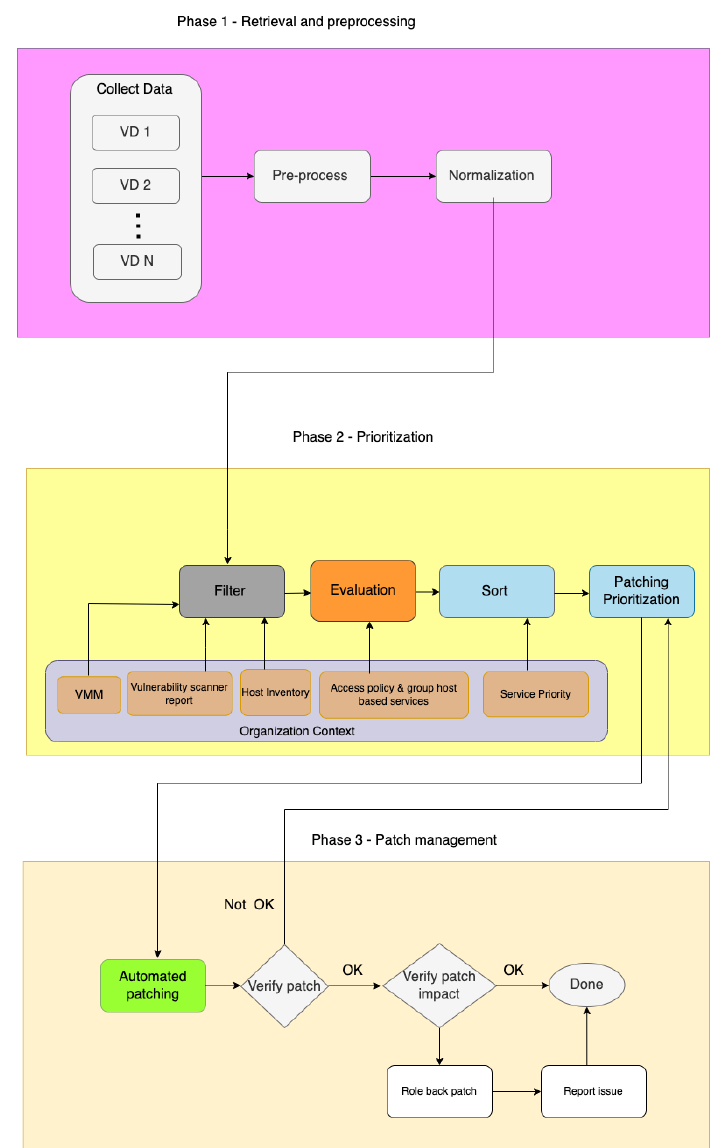
Figure 2. The ACVRM